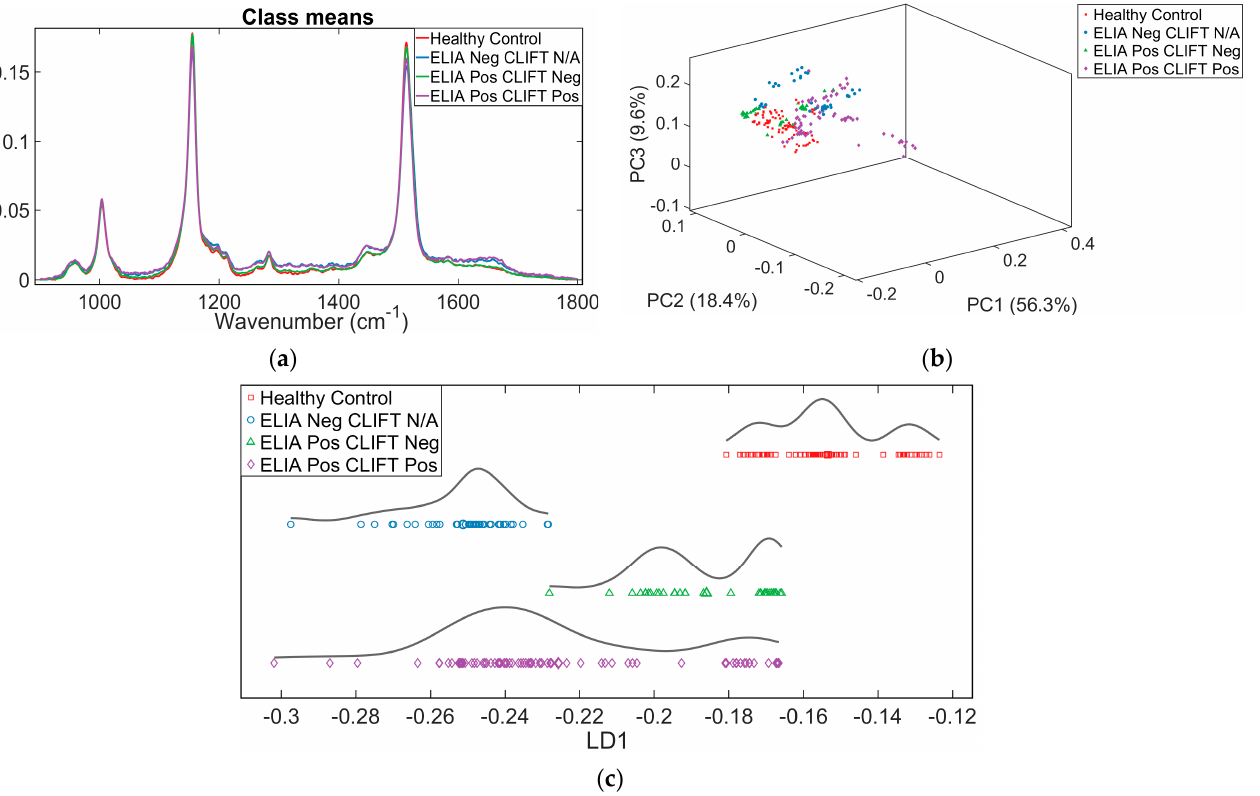
Figure 4. Raman data for SLE subgroups and HCs. SLE subgroups based on serological laboratory results (ELIA and CLIFT). ELIA Neg CLIFT N/A ( n = 2; 40 individual spectra); ELIA Pos CLIFT Neg ( n = 2; 40 individual spectra); ELIA Pos CLIFT Pos ( n = 4; 80 individual spectra); HC ( n = 4; 80 indi- vidual spectra). ( a ) Average pre-processed (Rubber band baseline correction, vector normalisation) Raman spectra cut to biological fingerprint region (900–1800 cm − 1 ). ( b ) The 3D PCA scatterplot. Pre-processed Raman data shows separation between groups using PC1, PC2 and PC3; HC—red, and SLE subgroups, ELIA Neg CLIFT N/A—blue, ELIA Pos CLIFT Neg—green, ELIA Pos CLIFT Pos—purple. ( c ) The 1D PCA-LDA scatterplot. PCA-LDA discriminant scores plot shows clear separation between the groups ( p -value < 0.001). HC—red, and SLE subgroups, ELIA Neg CLIFT N/A—blue, ELIA Pos CLIFT Neg—green, ELIA Pos CLIFT Pos—purple. p -value calculated based on a MANOVA test ( p = 4.90 × 10 − 4 ).